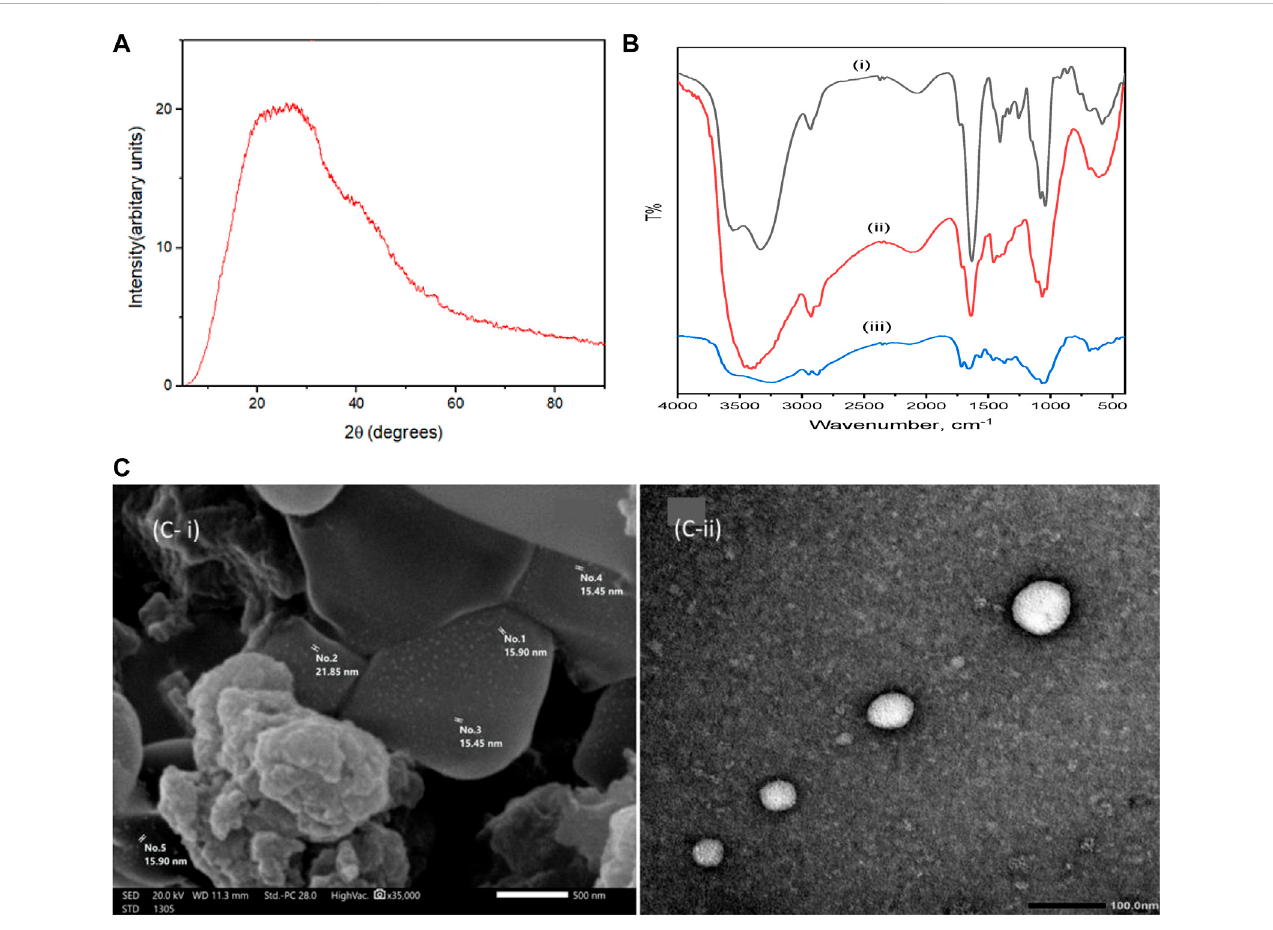
X-raydiffractionpatternof(CM- β CD:nChi:Glu), (A) ,FTIRspectraofCM- β CD (Bi) ,CM- β CD:nChi:Glu (Bii) ,andCM- β CD:nChi:Glu-afteradsorption (Biii) , SEM image (C i) and TEM image of CM- β CD:nChi:Glu (C ii)